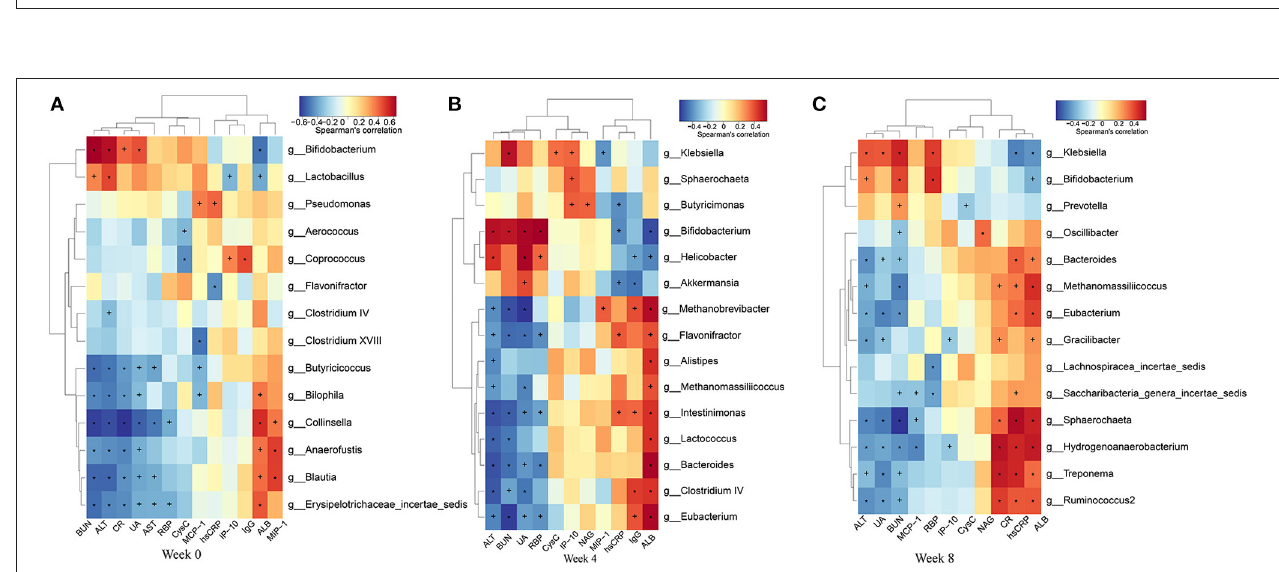
FIGURE 9 | Heatmaps of the correlation coefficients among the differential microorganisms of the rats in each group at 0 (A) , 4 (B) , and 8 (C) weeks. Coloring indicates the direction of association (blue: positive; red: negative). The degree of correlation is highlighted in color: the stronger the correlation, the darker the color.